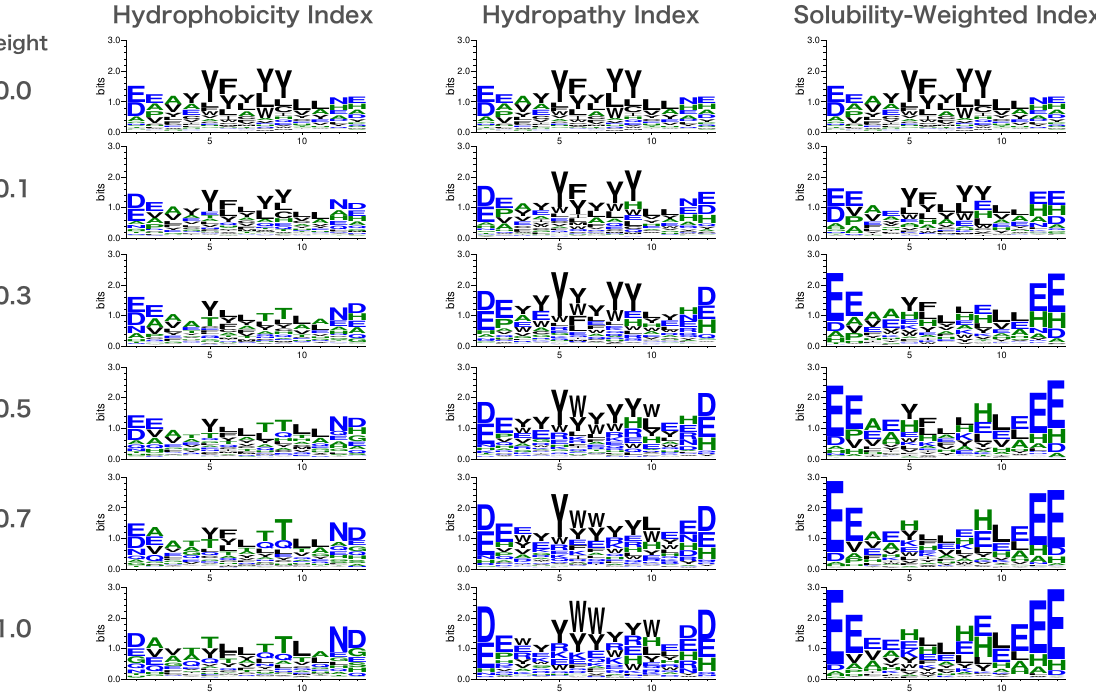
Figure 4. Sequence logos designed by AfDesign binder hallucination with solubility loss for each weight parameter. Hydrophilic amino acids (R, K, D, E, N, and Q) are shown in blue, neutral amino acids (S, G, H, T, A, and P) are shown in green, and hydrophobic amino acids (Y, V, M, C, L, F, I, and W) are shown in